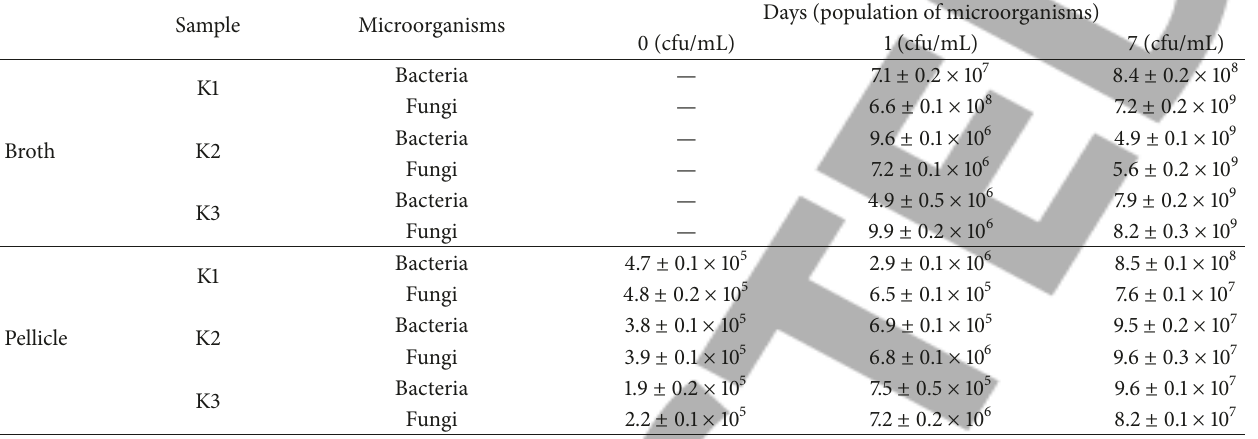
Table 2: Changes to the composition of the overall population of bacteria and fungi present in the broth and the pellicle prior to fermentation (day 0) and on day 1 and day 7.